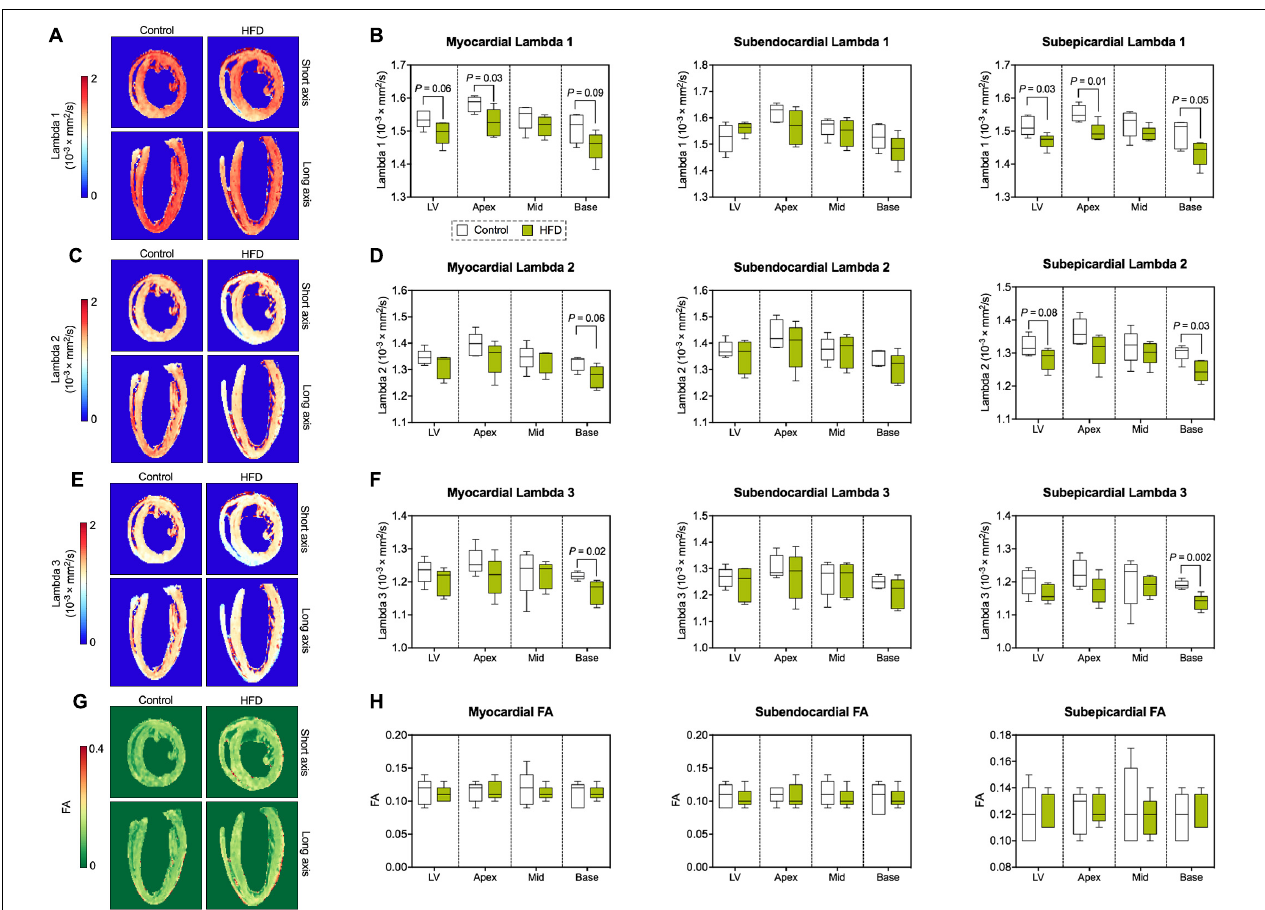
FIGURE 5 | Eigenvalues of the diffusion tensor and FA. (A) Representative maps of the first eigenvalue of the diffusion tensor (lambda 1). (B) Analysis of lambda 1 (largest eigenvalue). (C) Representative maps of the second eigenvalue of the diffusion tensor (lambda 2). (D) Analysis of lambda 2. (E) Representative maps of the third (smallest) eigenvalue of the diffusion tensor (lambda 3). (F) Analysis of lambda 3. (G) Representative FA maps. (H) Analysis of FA. Median and quartiles with 95% confidence interval; n = 5 per group; unpaired Student’s t -test or Mann-Whitney U